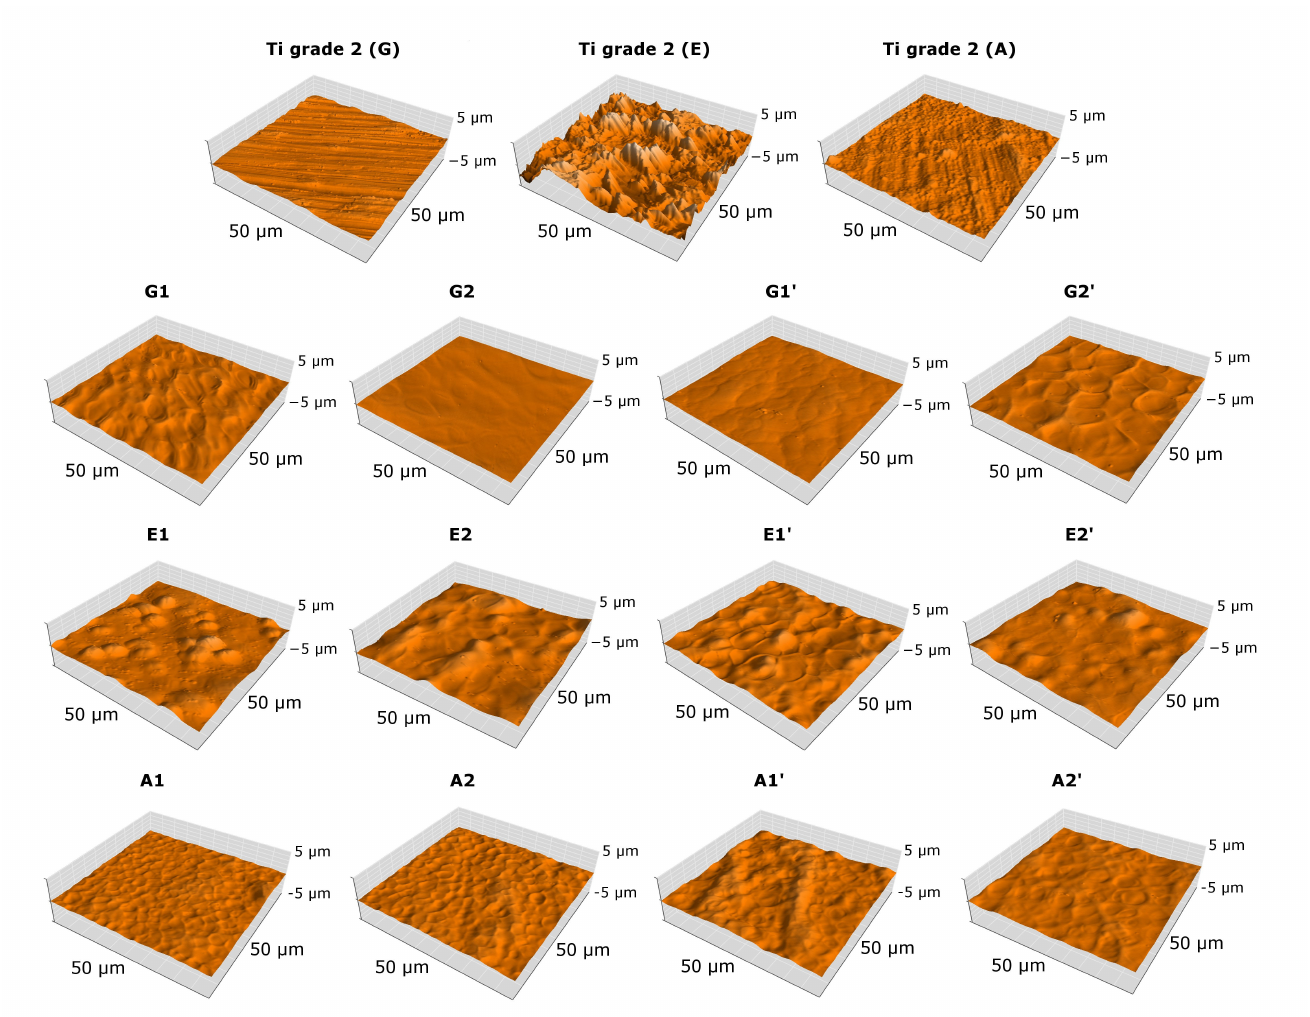
Figure 4. Surface topographies obtained by atomic force microscopy of the investigated